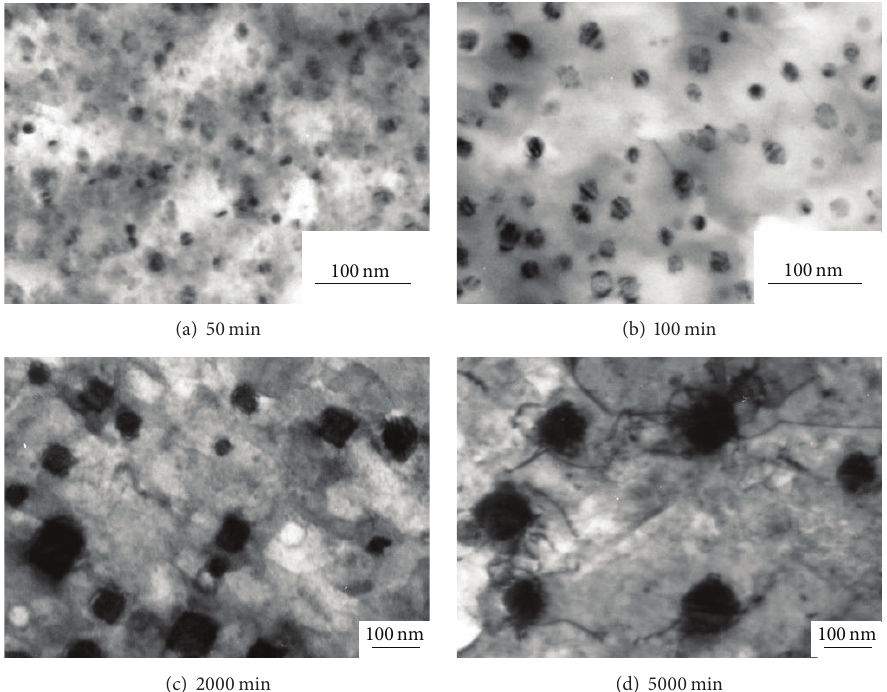
Figure 1: Bright field TEM images of Cu-1.8at%Fe-1.2at%Co annealed at 973